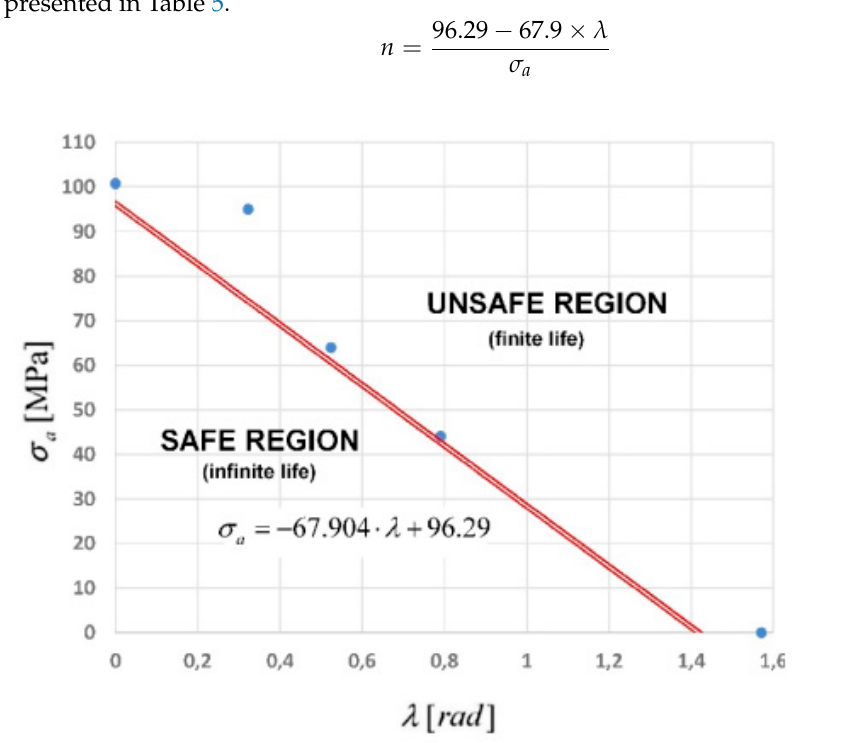
Figure 8. The threshold model to identify the safe region of AZ31B-F magnesium alloy based on the proportional loading conditions [24]. Table 5. The summary of novel research on the AZ31 magnesium alloys.